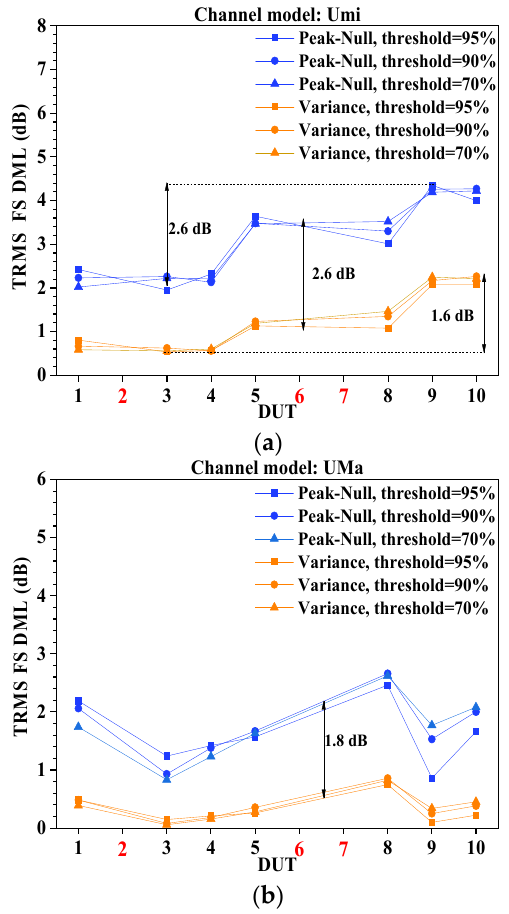
Figure 4. A comparison between Variance and Peak-Null for ( a ) the UMi and ( b ) the UMa channel models for TRMS under 3GPP UE noise-limited environmental condition.